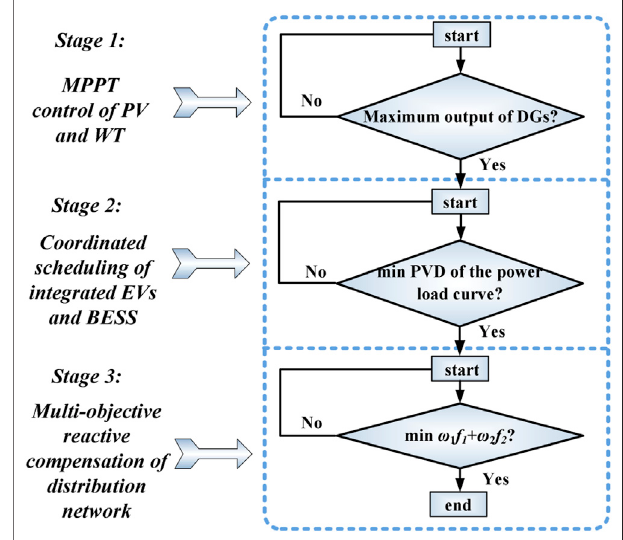
FIGURE 2 | Block diagram of the hierarchical optimization